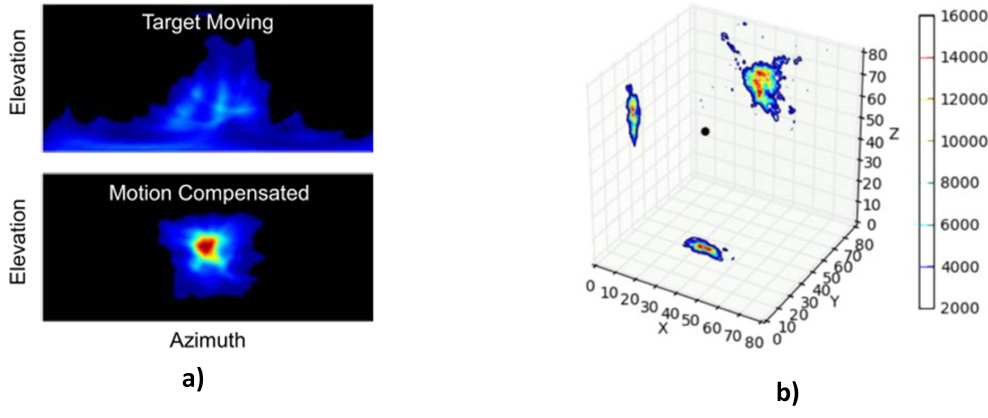
Figure 5. ( a ) Reconstructed image of moving source without (top) and with (bottom) motion compensation [27]; ( b ) 3D tomographic radiation source image on a stationary volume collapsed to the x - y , y - z , x - z planes